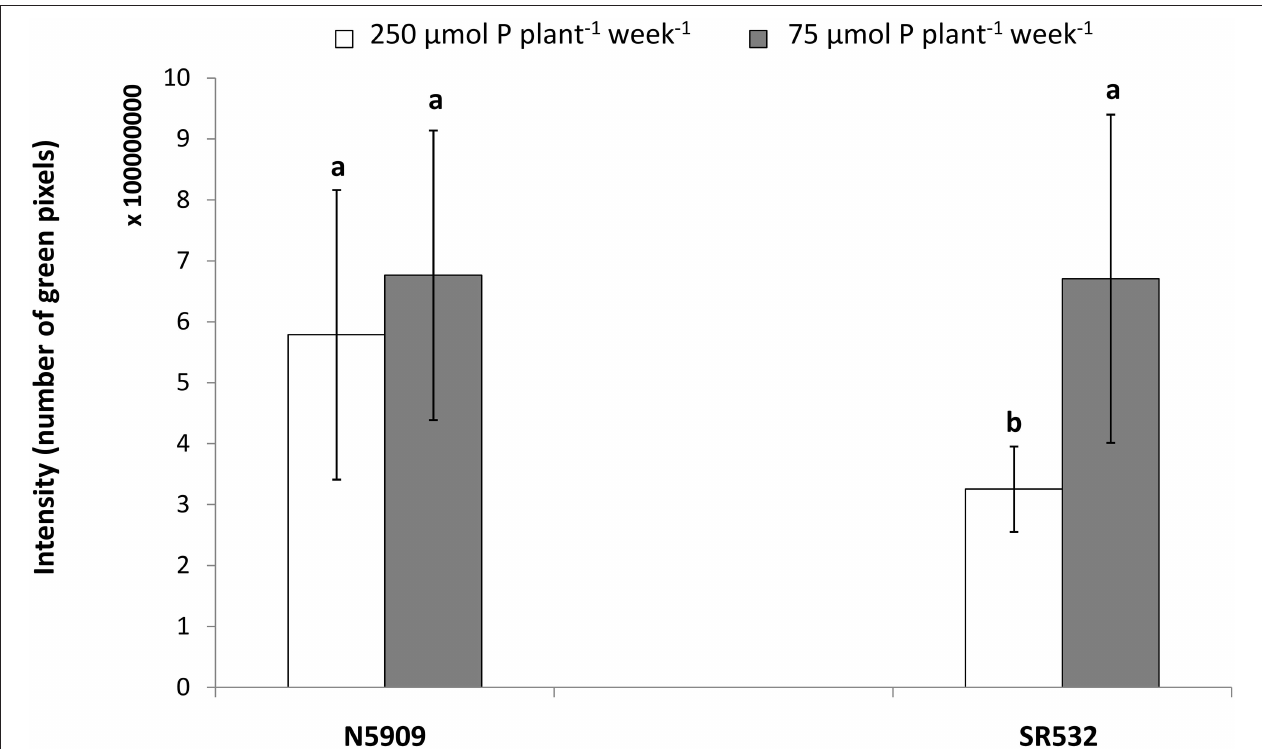
FIGURE 6 | Intensity of the fluorescent signal emitted by the rhizobial phytase transcripts in nodules sections of G. max cultivars N5909 and SR532 inoculated with B. elkanii SEMIA 587 under P sufficiency (250 µ mol P plant − 1 week − 1 ) (white) vs. P deficiency (75 µ mol P plant − 1 week − 1 ) (gray). Data represent average and standard deviation of three nodules of three plants. The y-axis intensity of fluorescence is expressed in number of green pixels and must by 10 8 . Treatments with a common letter are not significantly different ( p >